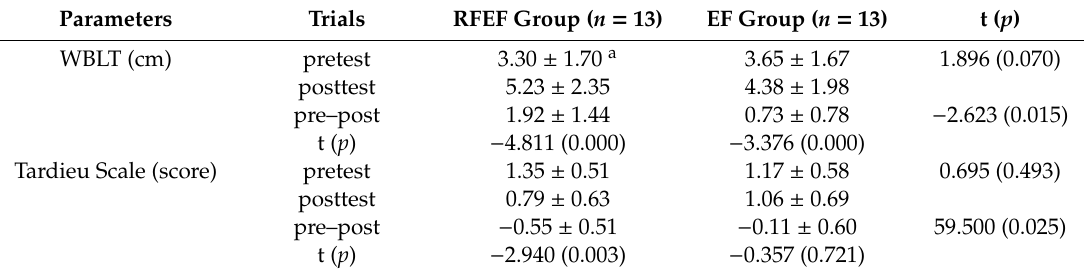
Table 2. Di ff erences in lower-limb function ( N = 26).